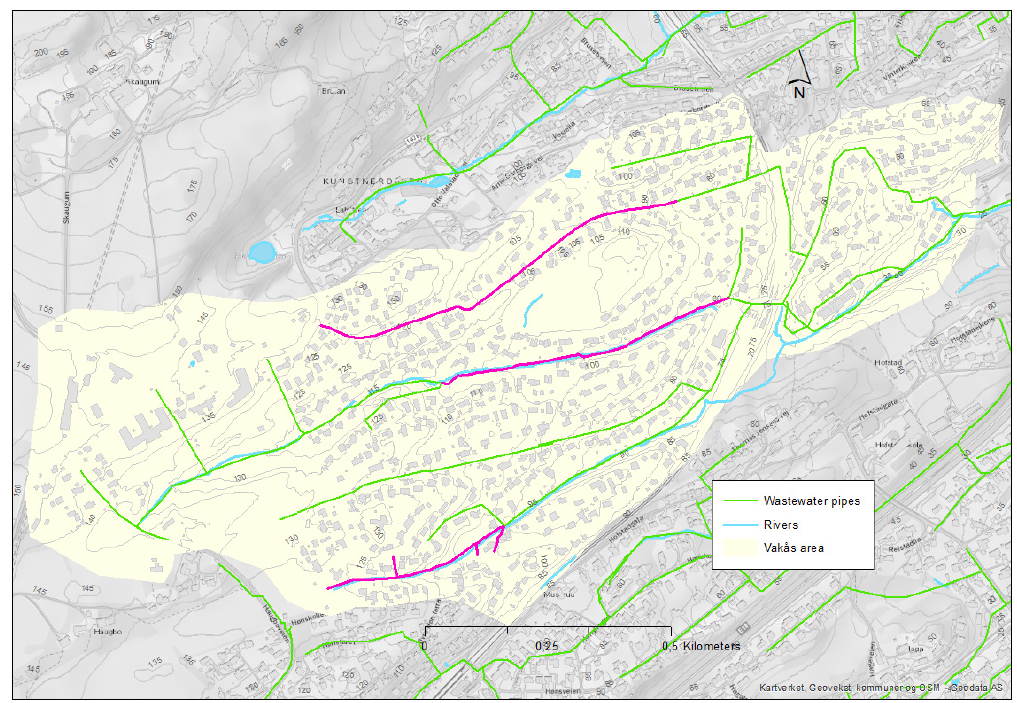
Figure 4. A map of the Vakås area. Pipes selected for rehabilitation are marked in the pink color.